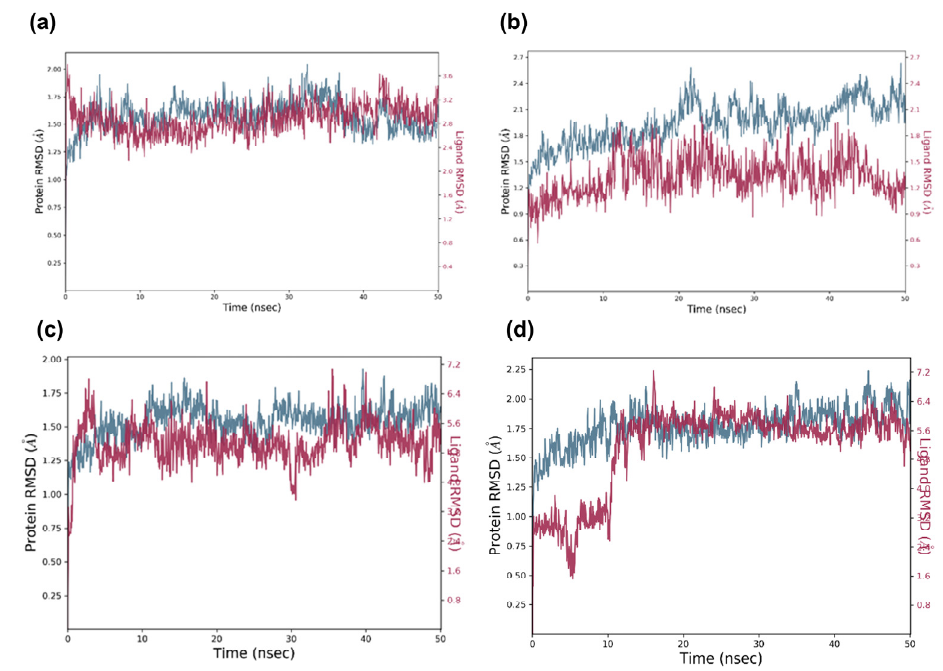
Figure 12. MD simulation trajectory (50 ns) analysis of the potential docked complexes via RMSD. In the time-dependent RMSD graph, C α -atoms of aromatase complex with identified potential virtual candidates, i.e., ( a ) candidate 1, ( b ) candidate 2, ( c ) candidate 3, ( d ) candidate 4. Aromatase C α -atom RMSD is shown in blue, whereas the RMSD of candidates for aromatase is shown in red.